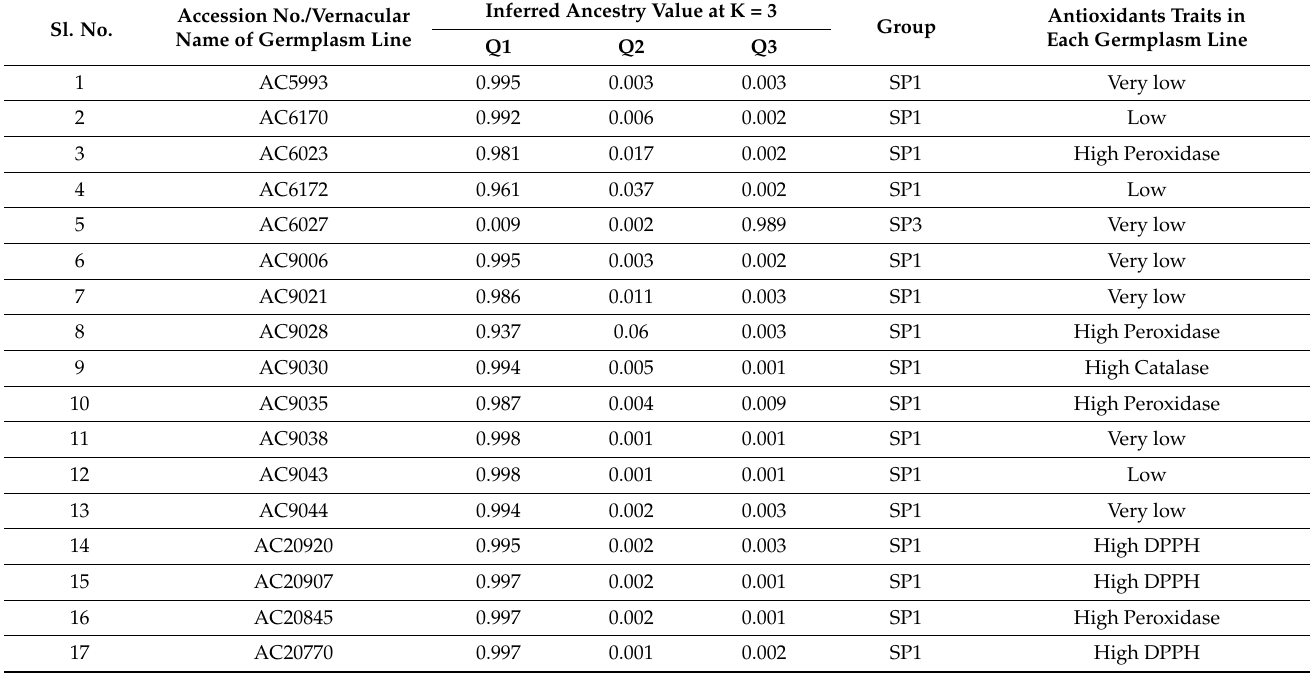
Table 2. The inferred ancestry value and population structure of individual members in the panel population with their antioxidant trait